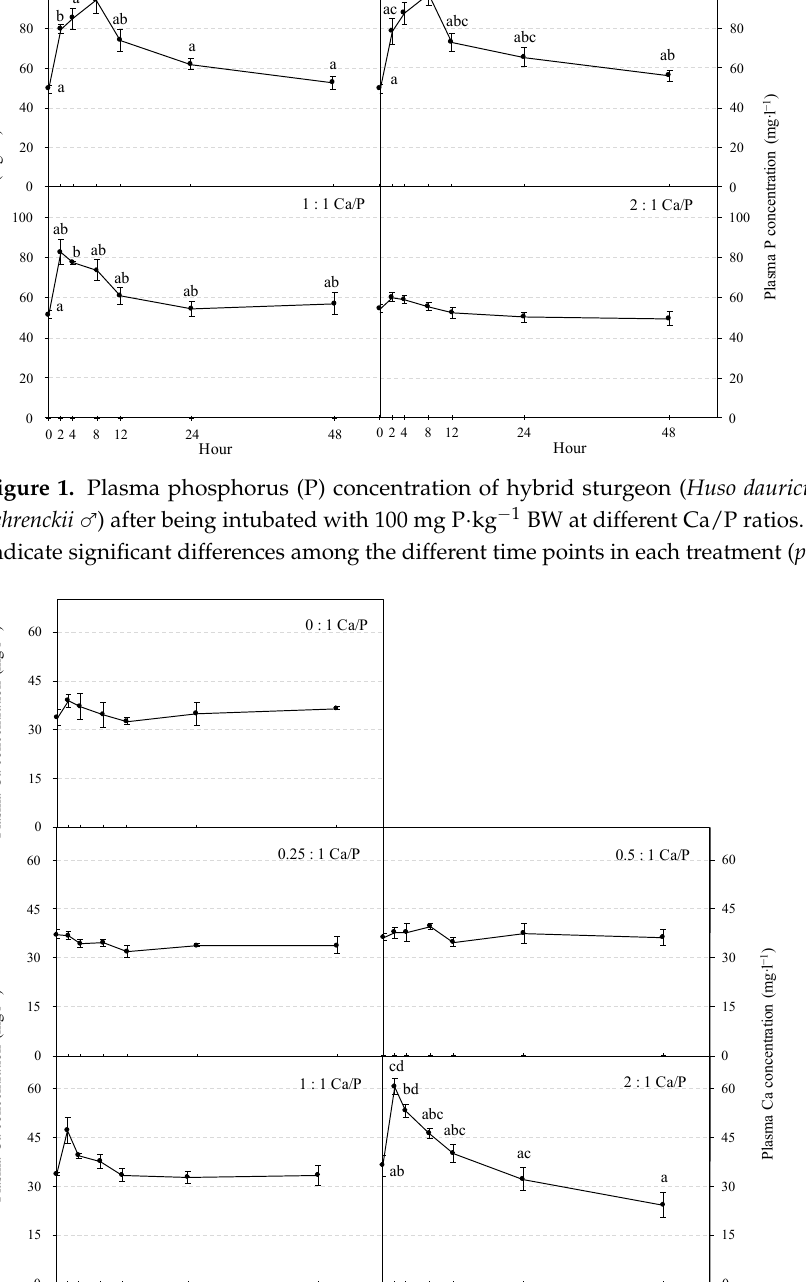
X Acipenser schrenckii ♀